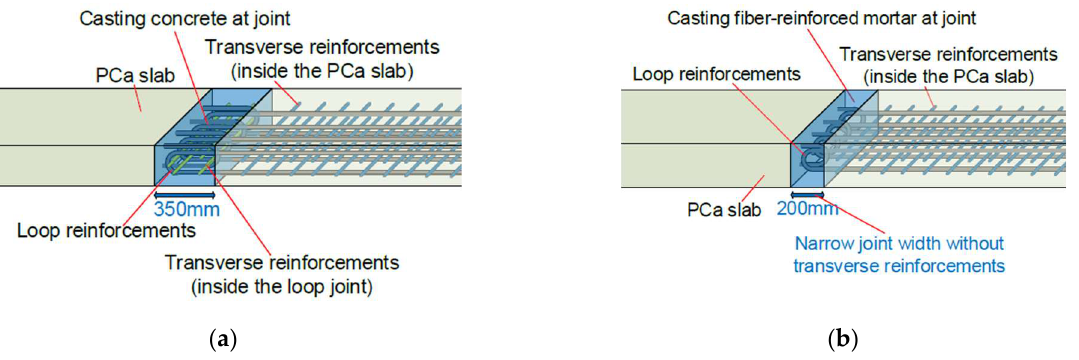
Figure 1. A loop joint connecting two precast concrete slabs: ( a ) conventional loop joint; ( b ) proposed narrow loop joint without transverse reinforcements.